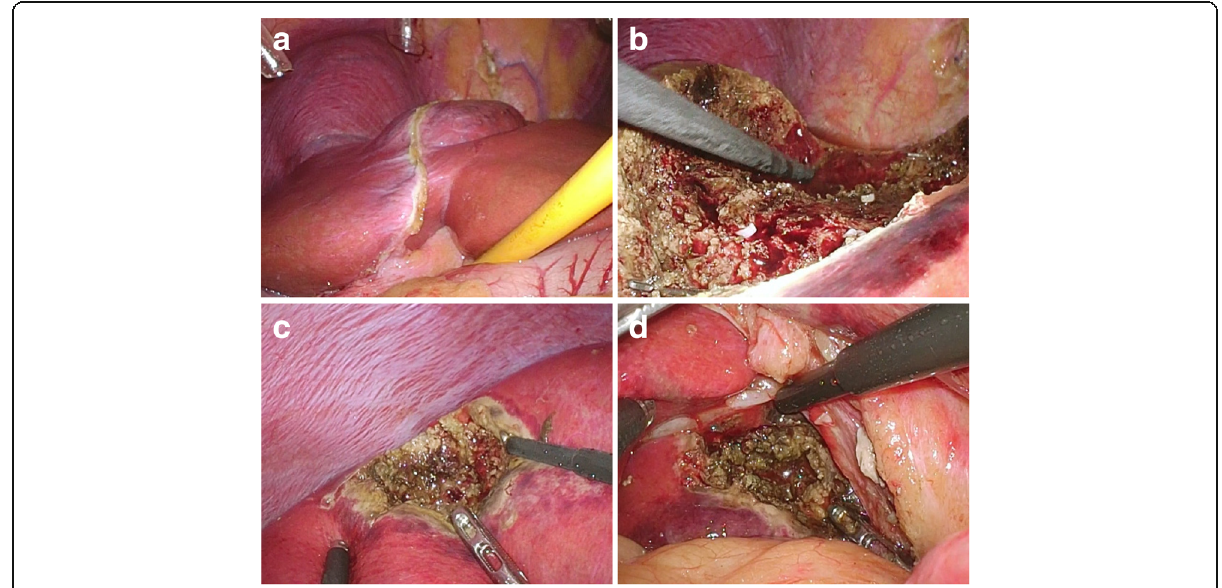
Fig. 3 Intraoperative findings during the laparoscopic partial liver resection. a Laparoscopy showing the largest tumor, which protruded out of the left lobe. b Gross appearance of the cut surface of segment 3/4. c Gross appearance of the cut surface of segment 8. d Gross appearance of the cut surface of segment